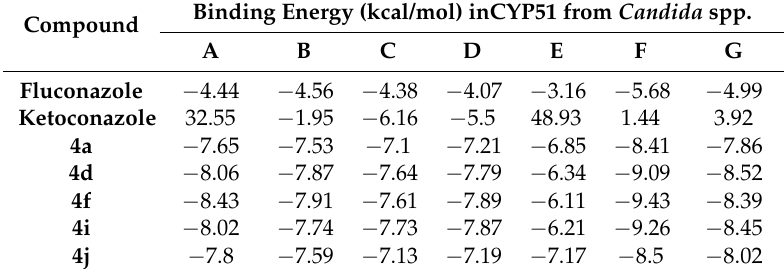
Table 3. Docking results of 3-benzoyl imidazo[1,2- a ]pyrimidines in the active site of CYP51 of Candida spp.